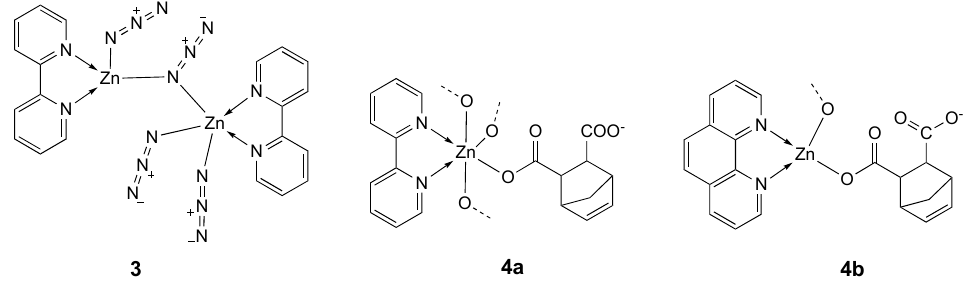
Figure 2. Structure of the zinc 2,2 ′ -bipyridine complexes 3 and 4a , 4b .